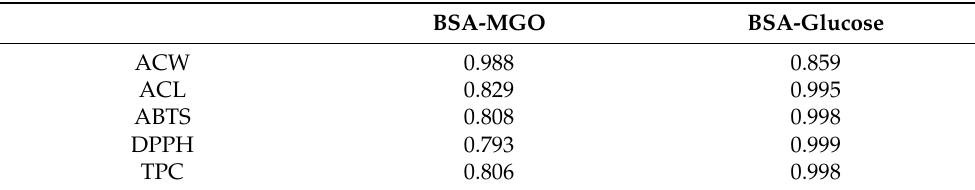
Table 6. Correlation coefficients for bovine serum albumin-methylglyoxal (BSA-MGO), BSA-glucose and antioxidant activity, and total phenolic content (TPC)